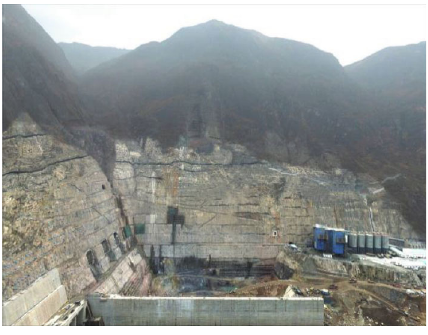
Figure 2: Engineering